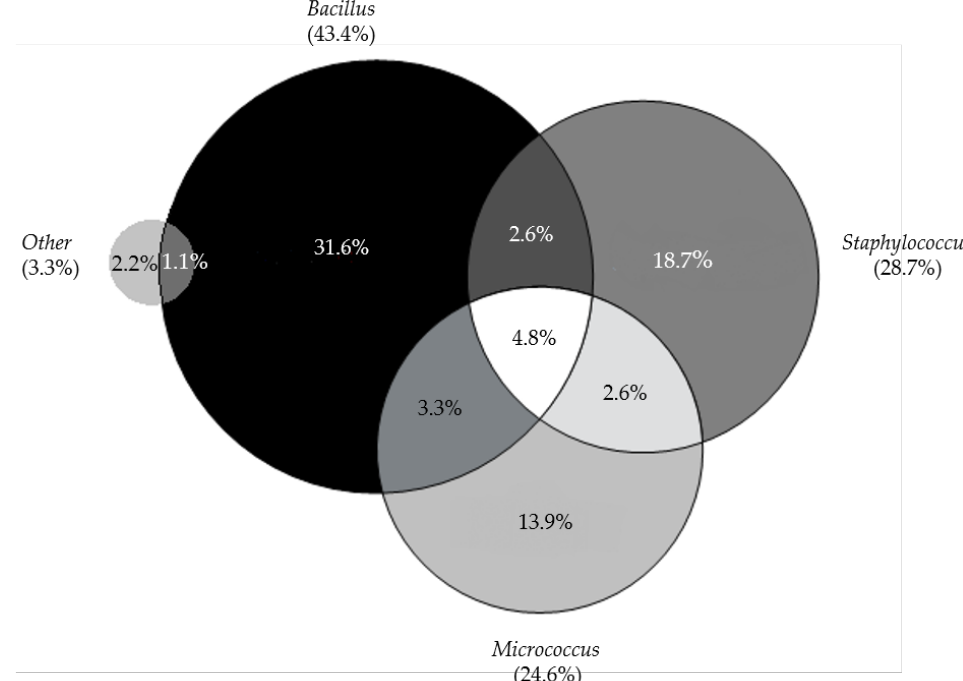
Figure 6. Microbial flora identified in the samples taken from the staff (glove prints and work clothing) during the entire trial. The circles representing individual genera are proportional to the frequency of occurrence (indicated in brackets), presented as % of each type of identification out of all identified samples.